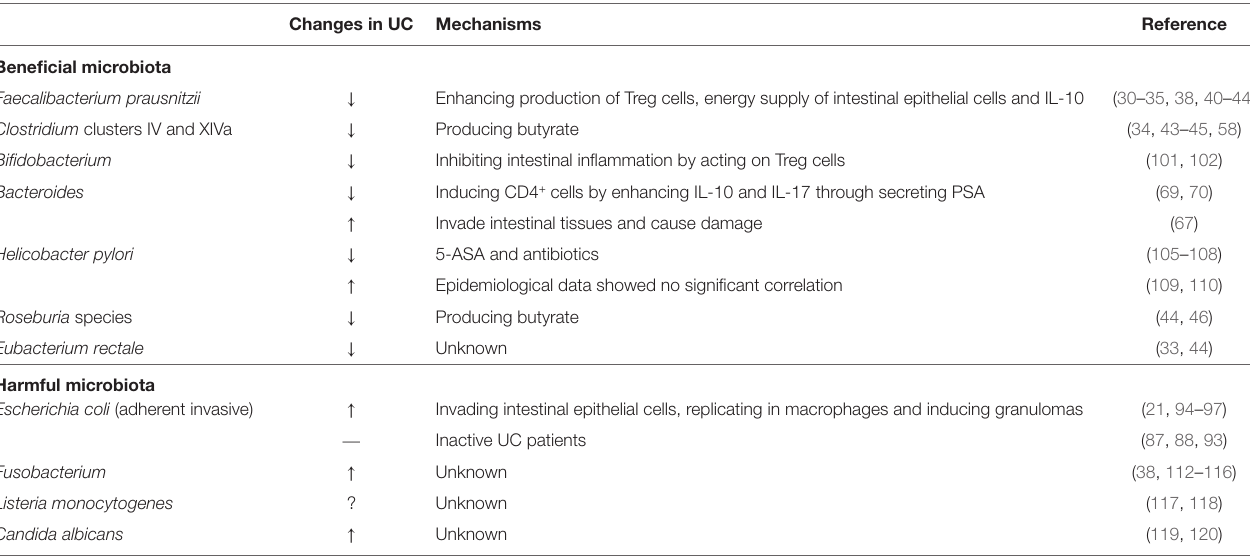
Table 1 | Changes of potential beneficial and harmful microbiota in UC. Changes in UC